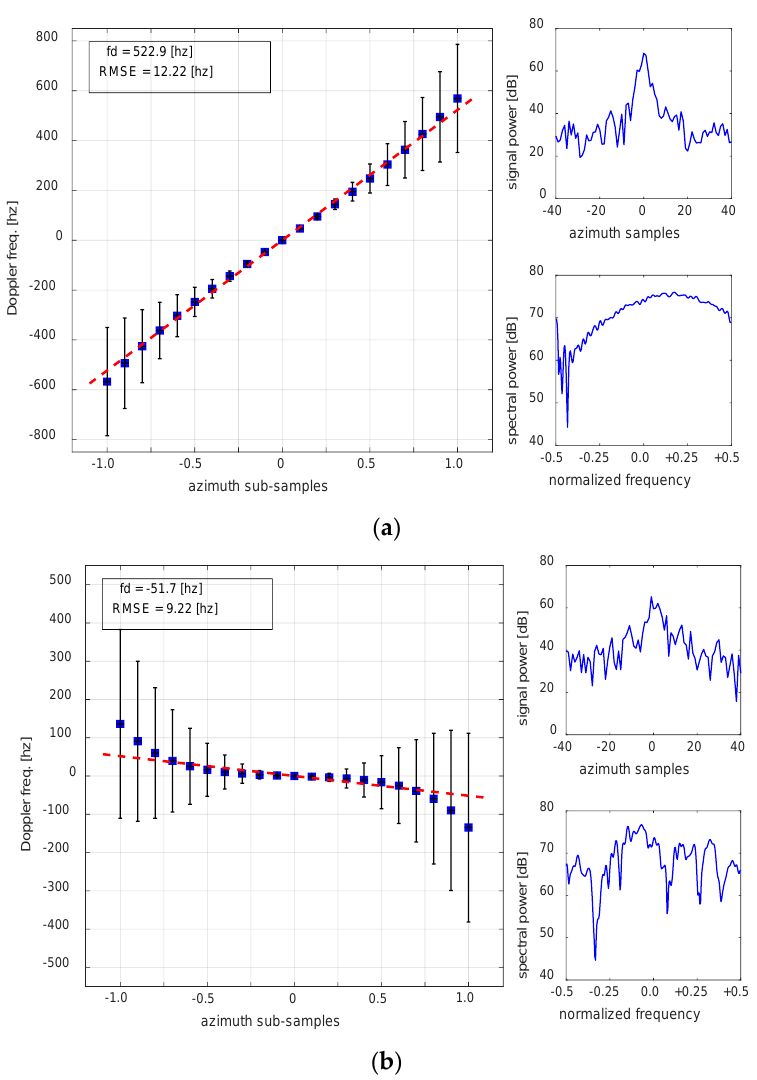
Figure 2. ( a ) Residual Doppler frequency estimation of the speed-controlled vehicle denoted by “A” in Figure 1a. The SAR-measured range velocity by the proposed method is − 51.4 ± 1.20 km/h, while that recorded by GPS on the car is 49.6 km/h. The peak-to-sidelobe ratio (PSLR) of the vehicle is − 11.4 dB, with a signal-to-clutter ratio (SCR) of 41.1 dB. ( b ) Residual Doppler frequency estimation of the detected target “B” in Figure 1a. The SAR measured range velocity is approximately 5.1 ± 0.91 km/h, with an azimuth velocity of approximately 9.8 km/h. The PSLR of the target is − 7.4 dB, with an SCR of 27.3 dB. While the Doppler spectrum (bottom right in each sub-figure) of targets with high PSLR and SCR well-depicts the Doppler centre frequency as in ( a ), it is difficult to determine a centre frequency from the Doppler spectrum of weak point targets, as seen in ( b ).